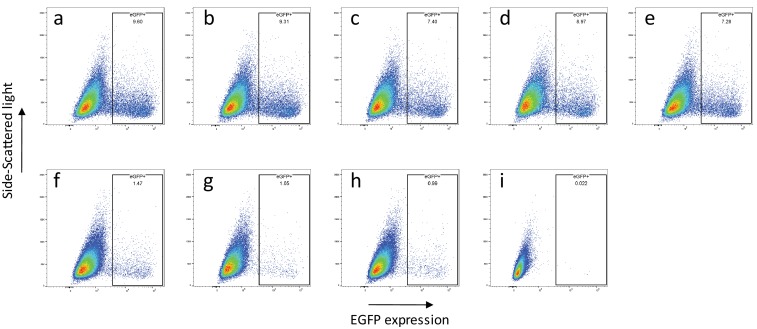
CpG and UpA dinucleotides inhibit initiation of E7 replicon RNA replication.FACS analysis quantified the number of EFP expressing RD cells after transfection of EGFP expressing E7 replicon RNA containing (a) R2_WT and ncR1 _WT, (b) R2_WT and ncR1_P, (c) R2_WT and ncR1_cu, (d) R2_WT and ncR1_U, (e) R2_WT and ncR1_C, (f) R2_C and ncR1_WT, (g) R2_C and ncR1_C, (h) R2_U and ncR1_U and (i) mock transfected sequences. Plots are representatives of three biological replicates.